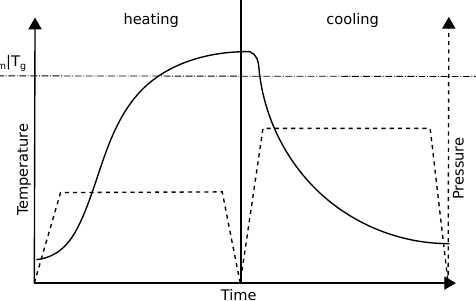
Figure 7. Example temperature and pressure profiles of a random composite material during the heating and cooling phases of a consolidation process.